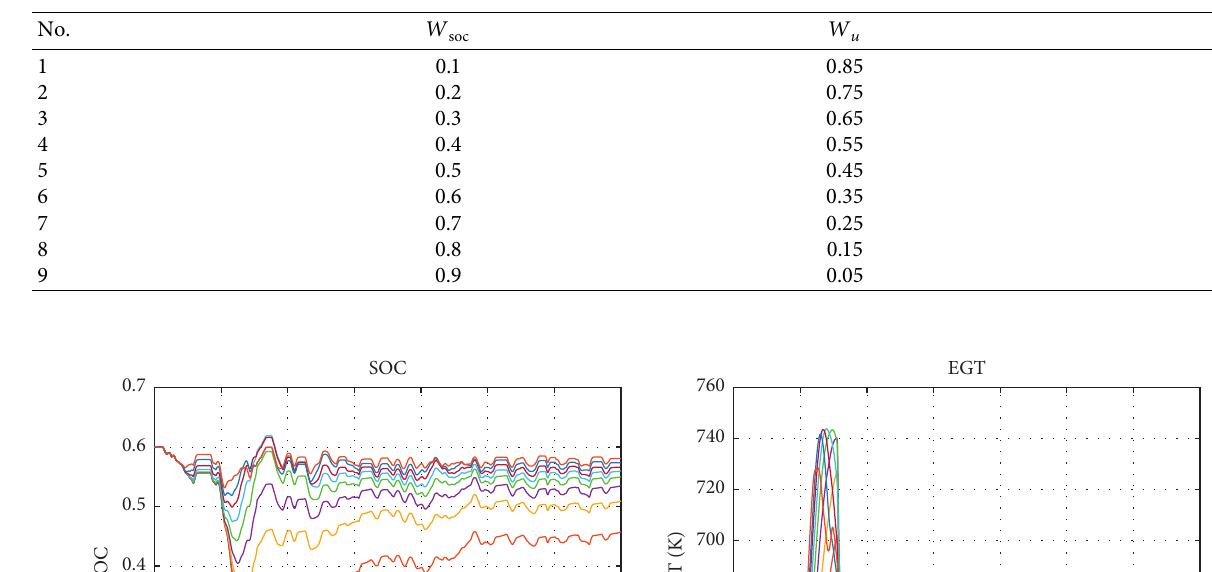
Table 9: Configuration of weight coefficient.